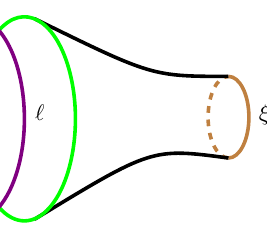
Figure 6 . Trumpet capped by the FZZT brane shown by a brown circle and parametrized by ξ